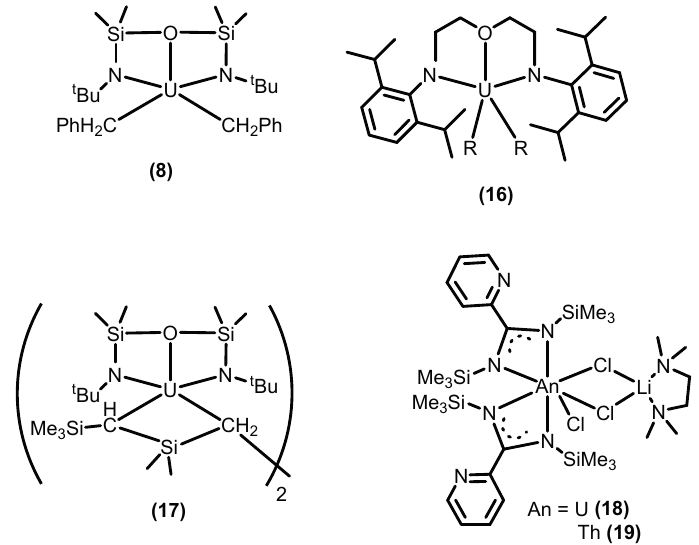
Figure 7. Diamino ether uranium (IV) complexes and bis(amidinate) actinide complexes used as pre-catalysts in the polymerization of ethylene